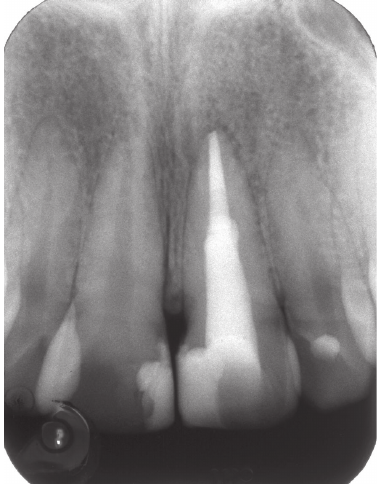
Figure 11: Radiograph at 3 months after surgery.